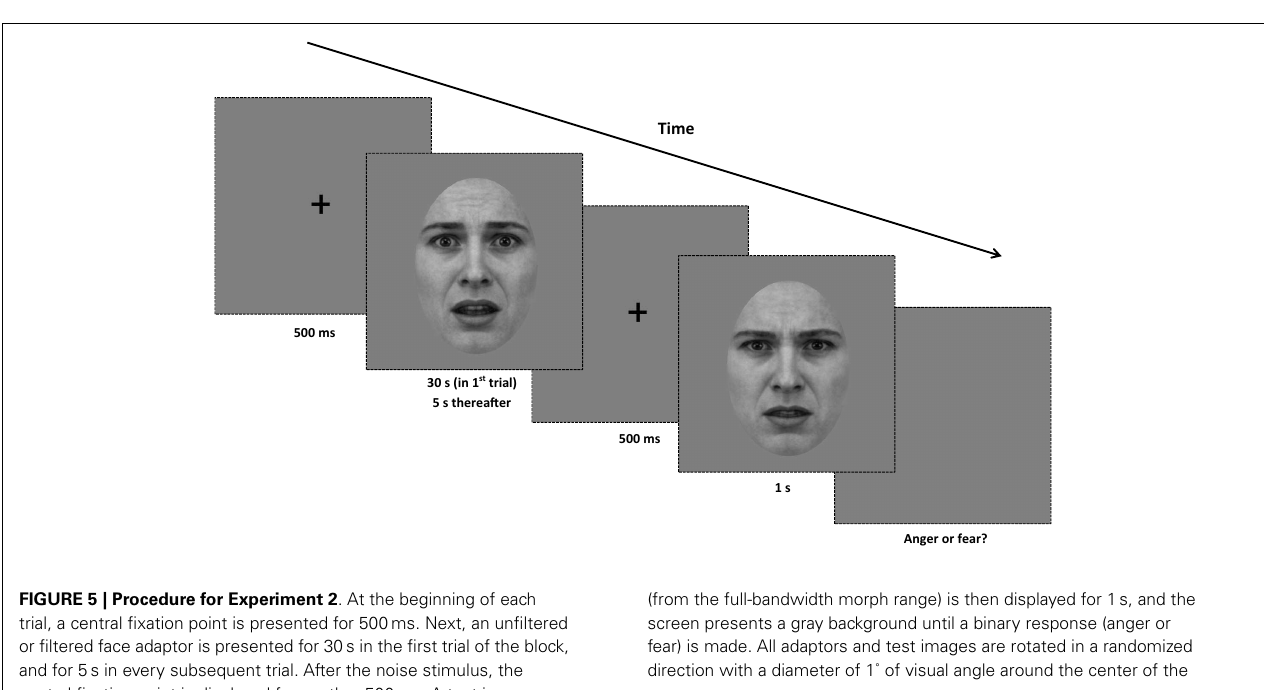
FIGURE 5 | Procedure for Experiment 2 . At the beginning of each trial, a central fixation point is presented for 500ms. Next, an unfiltered or filtered face adaptor is presented for 30s in the first trial of the block, and for 5s in every subsequent trial. After the noise stimulus, the central fixation point is displayed for another 500ms. A test image